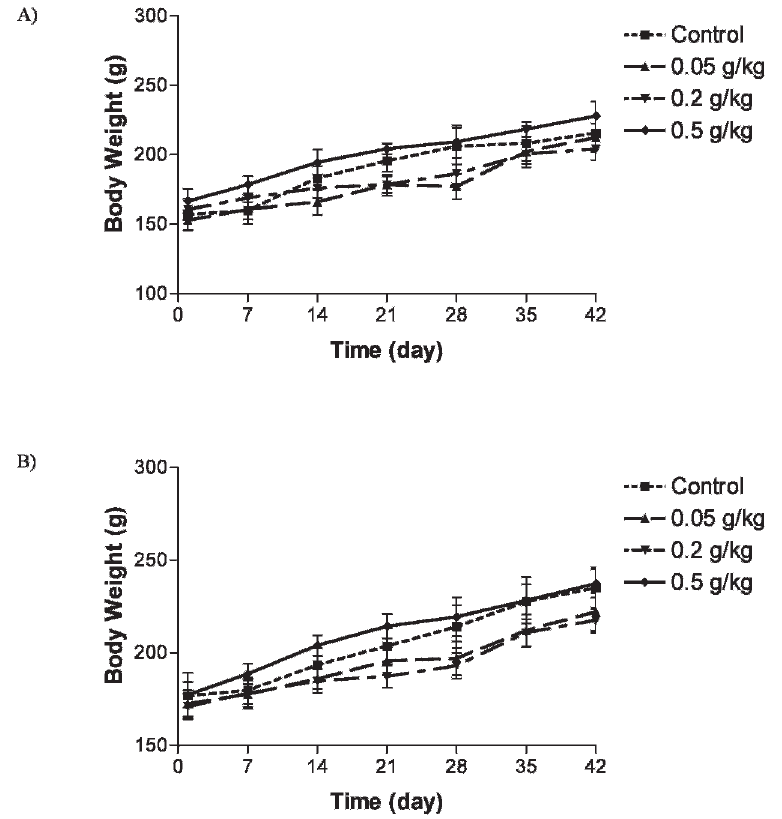
Figure 2 - Changes in male (A) and female (B) rats body weight with duration of subchronic treatment. Each point represents mean ¡